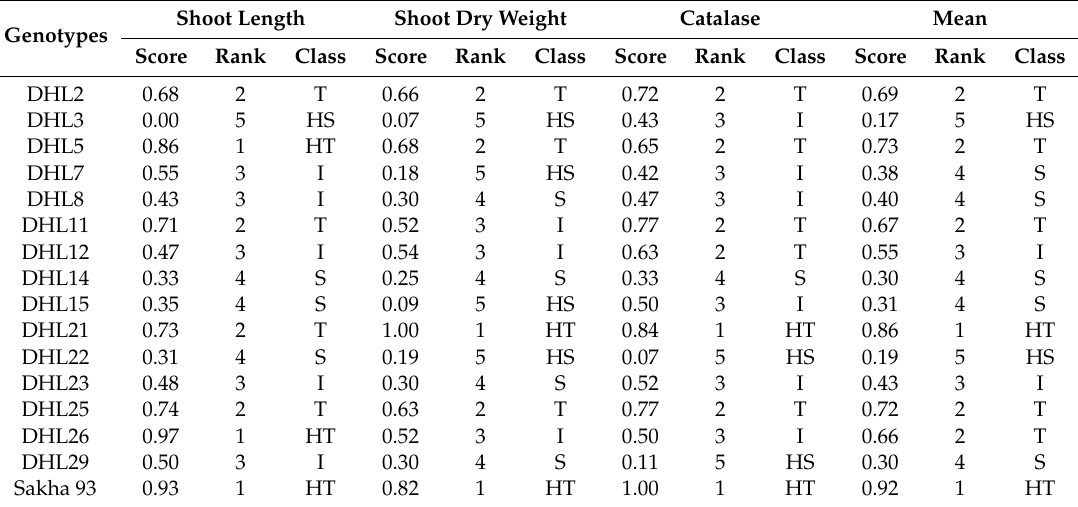
Table 7. Membership index for the 16 wheat genotypes based on three selected traits (shoot length, shoot dry weight, and